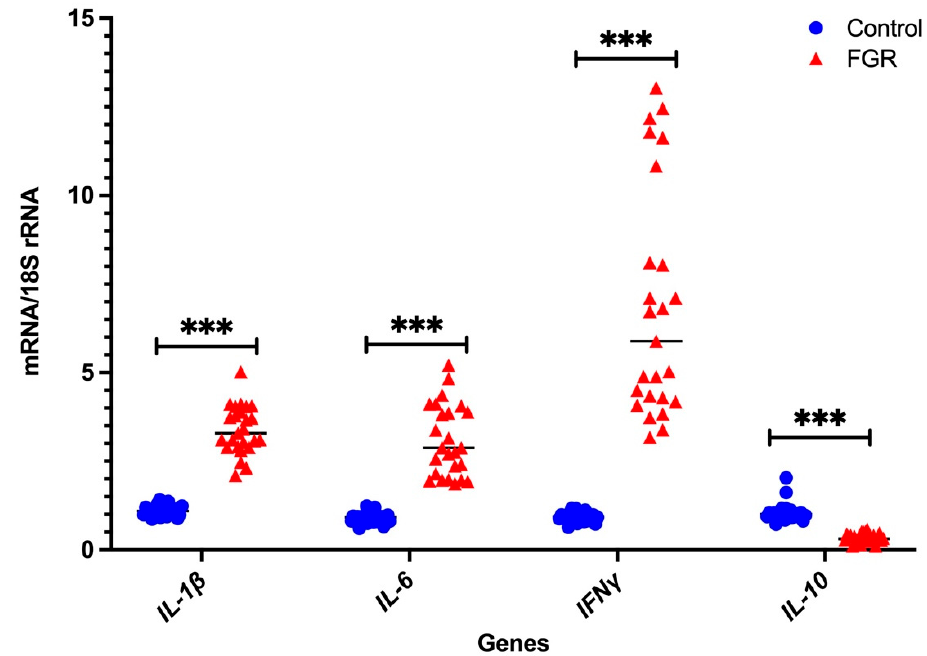
Figure 2. Real-time PCR validation of pro- and anti-inflammatory cytokines: independent validation of mRNA expression of the pro- and anti-inflammatory cytokines relative to 18S rRNA . Statistical significance was determined using a Mann–Whitney U test and indicated by *** ( p < 0.001).